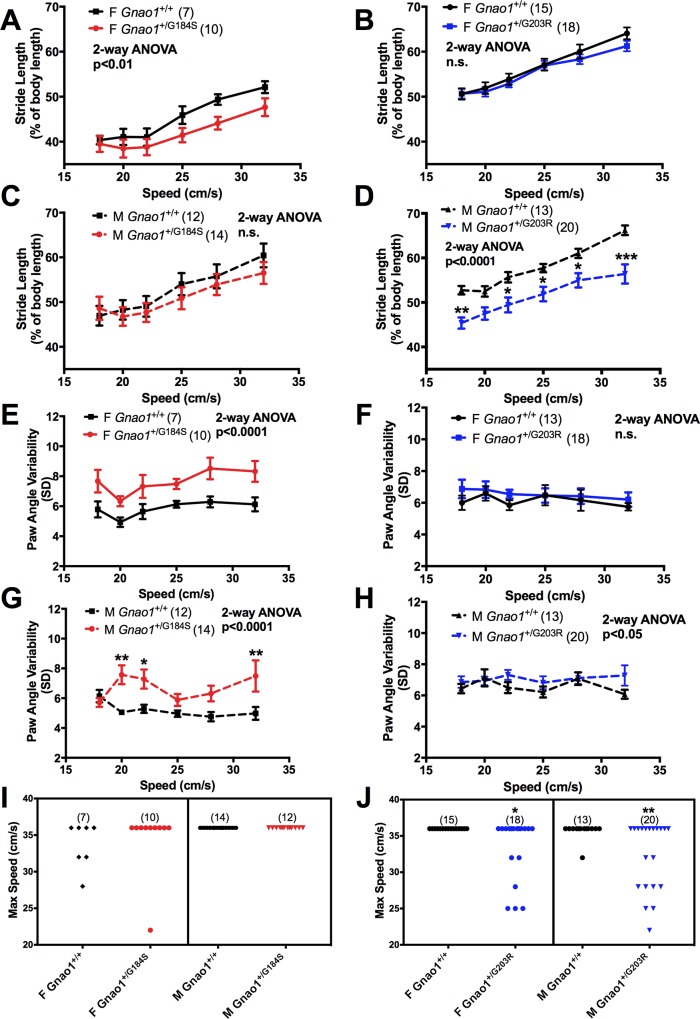
DigiGait imaging system reveals sex-specific gait abnormalities in Gnao1+/G184S mice and Gnao1+/G203R mice.(A-D) Female Gnao1+/G184S mice showed significant gait abnormalities, while female Gnao1+/G203R mice remain normal. (A & B) Female Gnao1+/G184S mice showed reduced stride length (2-way ANOVA with Bonferroni multiple comparison post-test) while female Gnao1+/G203R mice were not different from control (2-way ANOVA; n.s.). (C) Female Gnao1+/G184S mice also showed increased paw angle variability (2-way ANOVA, p<0.0001) while female Gnao1+/G203R mice showed normal paw angle variability. (E-H) Male Gnao1+/G203R and Gnao1+/G184S mutant mice showed distinct gait abnormalities. (E & G) Male Gnao1+/G184S mice showed significantly increased paw angle variability (2-way ANOVA p <0.0001 overall with significant Bonferroni multiple comparison tests; **p<0.01 and *p<0.05). There was no effect on stride length. (F & H) In contrast, male Gnao1+/G203R mice showed markedly reduced stride length (2-way ANOVA p<0.0001 with Bonferroni multiple comparison post-test; ***p<0.001, **p<0.01, and *p<0.05) and modestly elevated paw angle variability (overall p<0.05). (I) Gnao1+/G184S mice did not show significant differences in the highest treadmill speed successfully achieved. (J) Both male and female Gnao1+/G203R mice showed reduced capabilities to run on a treadmill at speeds greater than 25 cm/s (Mann-Whitney test; *p<0.05).